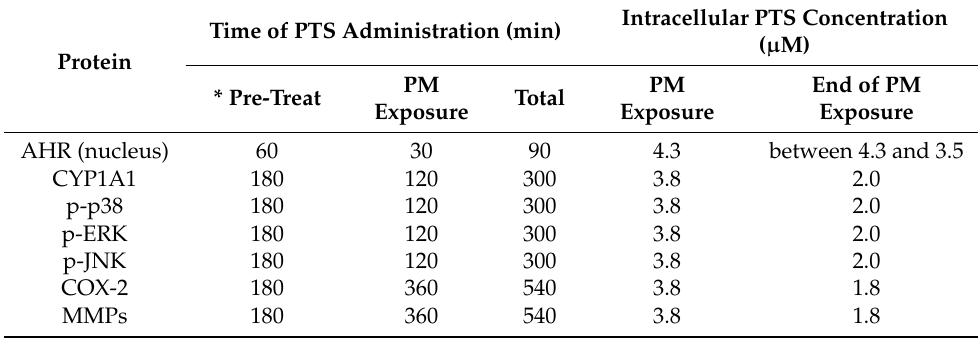
Figure 6. Time-dependent changes in the concentration of PTS in HaCaT cells and culture medium. Table 1. The PTS concentration required to inhibit various PM-induced intracellular proteins.